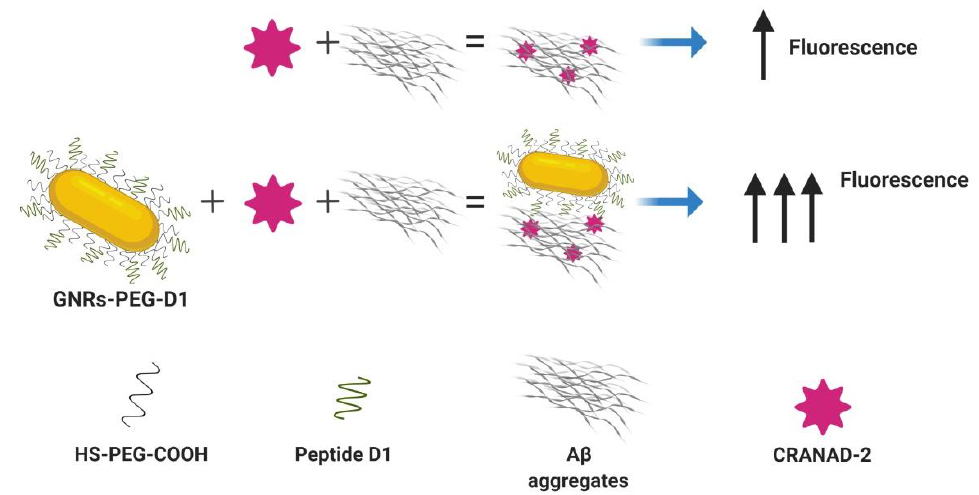
Figure 3. Gold nanorods (GNRs) functionalized with the peptide D1 allow the enhancement of a fluorescence signal of CRANAD-2 associated with amyloid beta peptide (Aβ) aggregates.